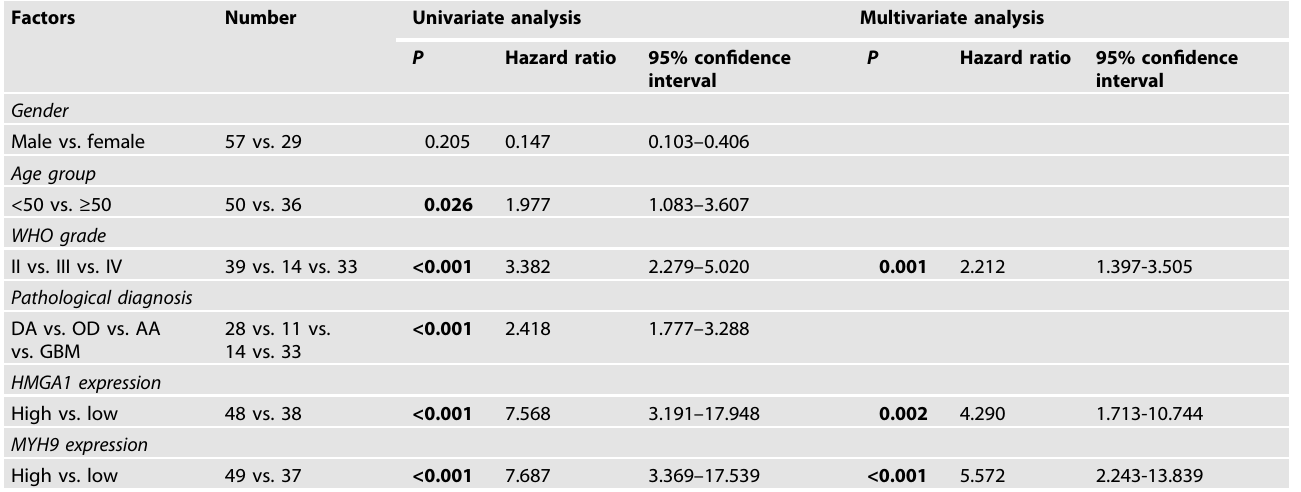
Table 2. Summary of univariate and multivariate Cox regression analysis of overall survival duration.